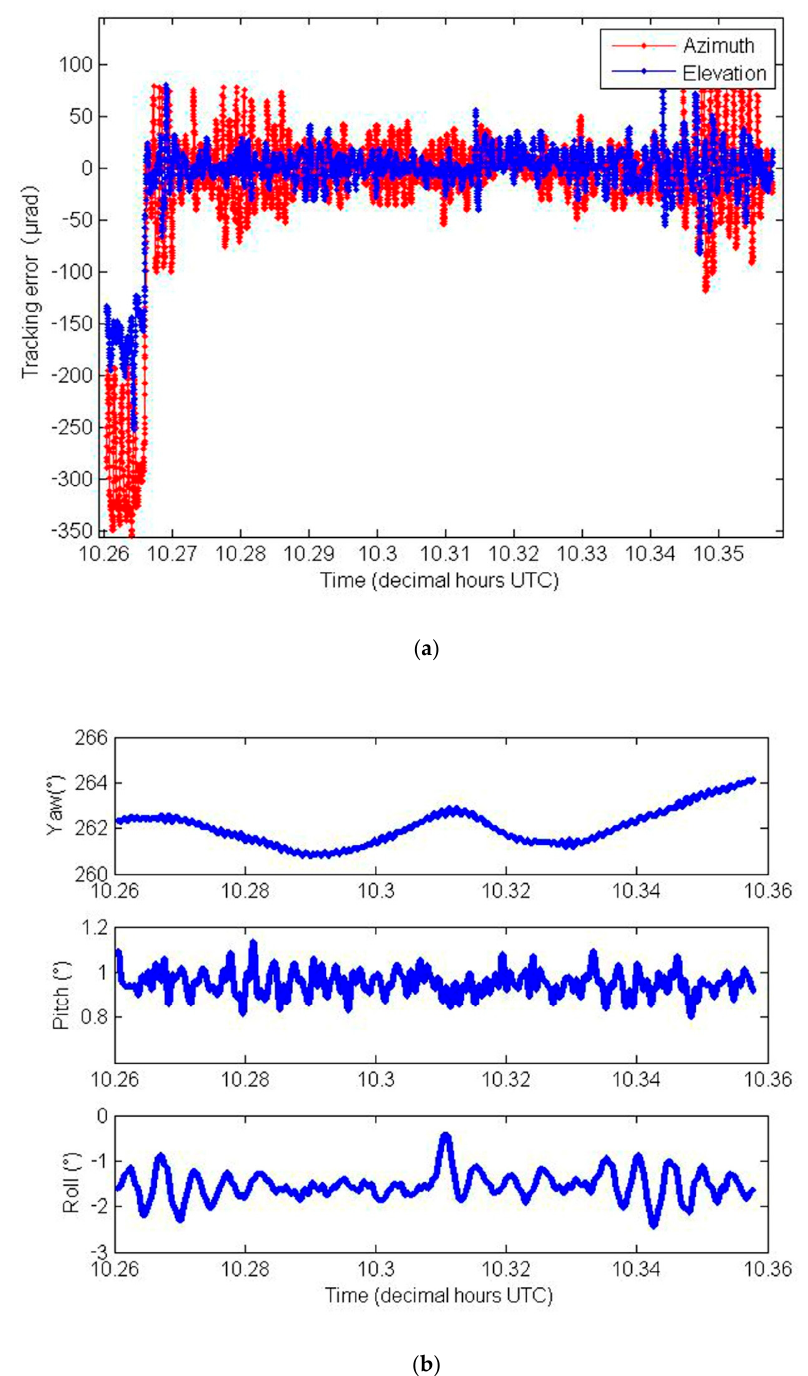
Figure 10. The shipborne ATP acquired and tracked the performance of a satellite. ( a ) The tracking error for the entire process and the initial error just appear in the field of view. The azimuth initial acquisition error was 310 µ rad whereas the elevation initial acquisition error was 160 µ rad. When the spot was in the tracking field, the azimuth tracking error was about 19.5 µ rad (RMS) while the elevation tracking error was about 14.6 µ rad (RMS). The tracking error in the stabilized time lasted from 10:15:58 to 10:21:28, about 330 seconds. ( b ) Ship attitude measurement. The yaw, pitch, and roll curves of the ship measured by the GPS / INS